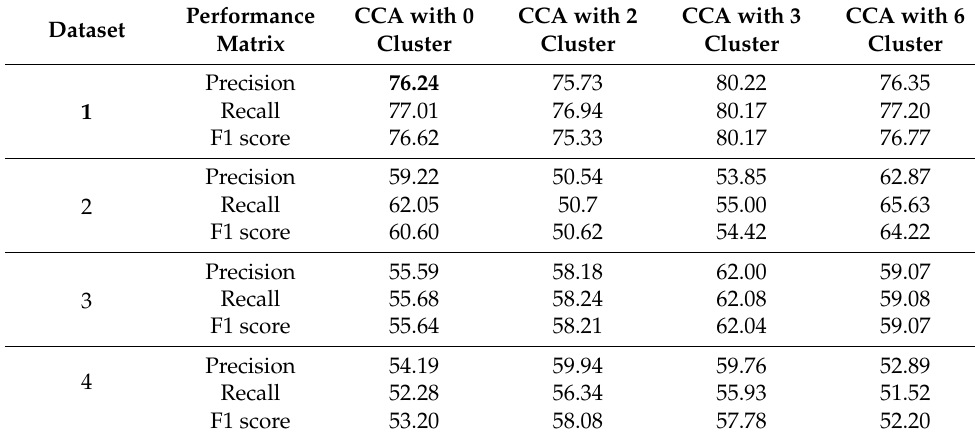
Table 4. Results of F1-Score, Precision, and Recall for CCA.